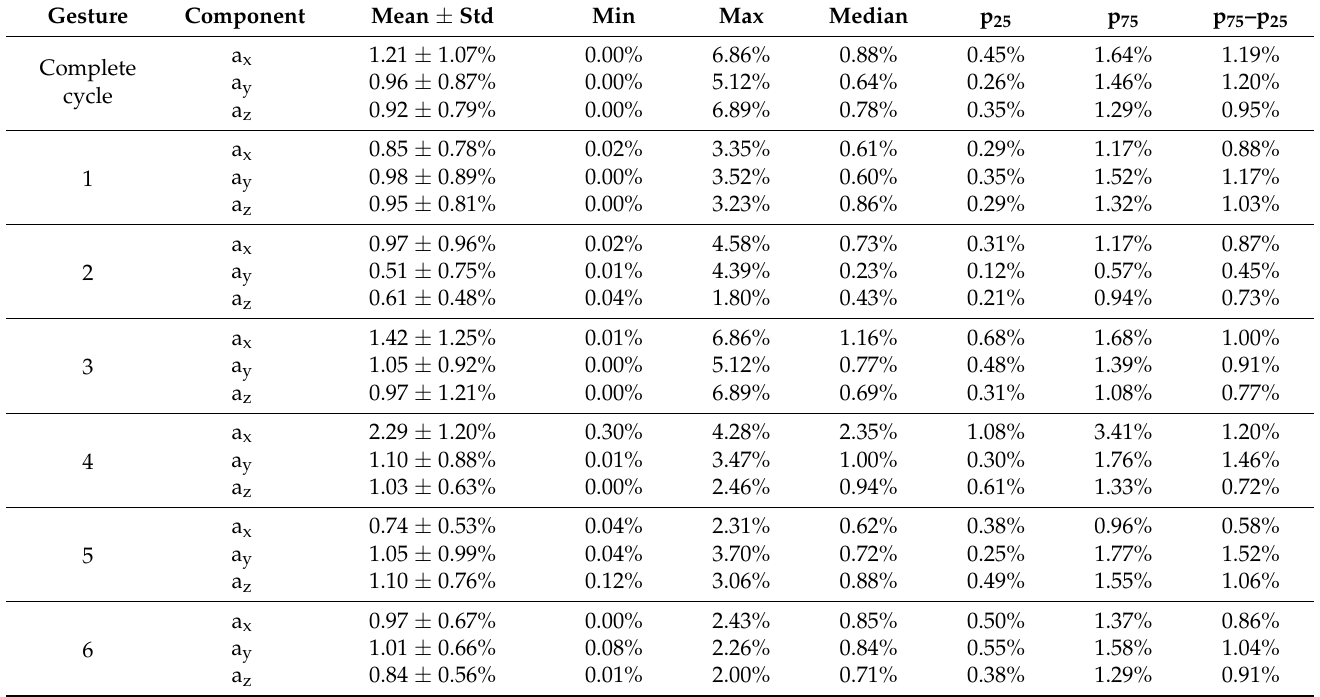
Table 7. Descriptive statistics obtained based on the accelerometer